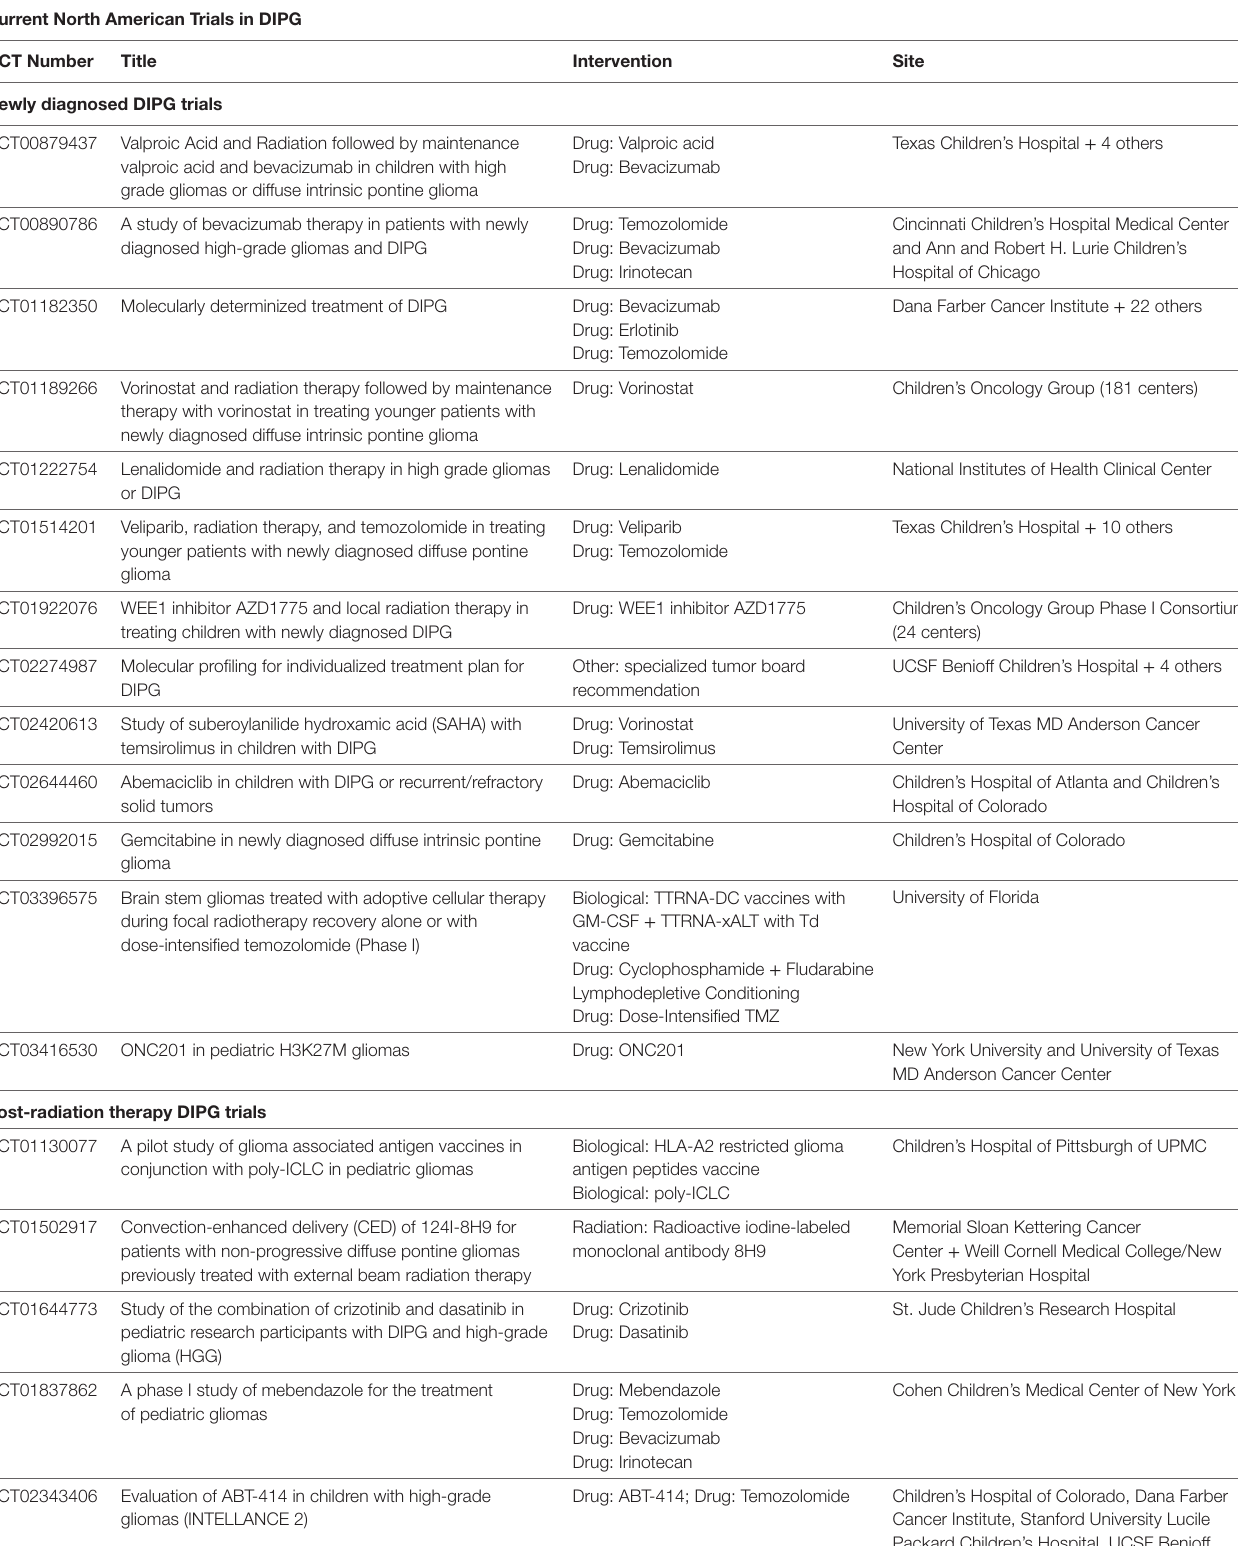
TABLe 1 | Active North American clinical trials for children with diffuse intrinsic pontine gliomas (DIPG) as found on www.Clinicaltrials.gov as of March 1, 2018. Current north American Trials in